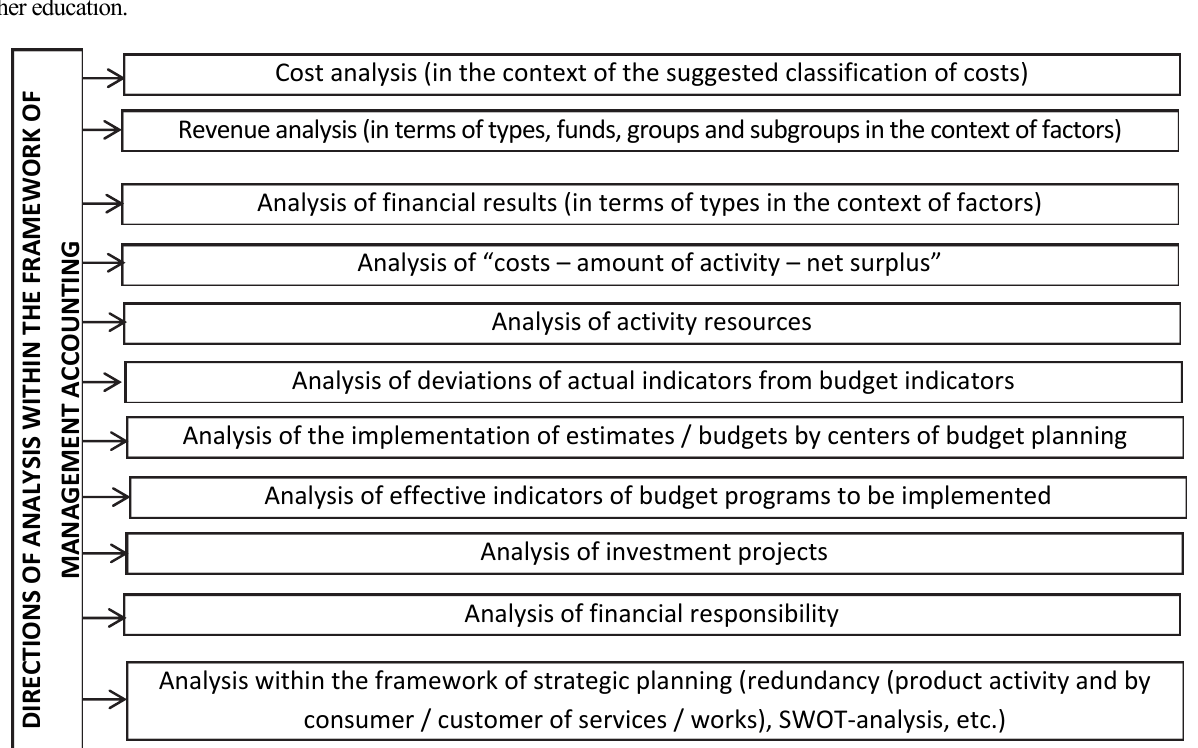
Fig. 1. Vector directions of analysis within the analytical cluster of management